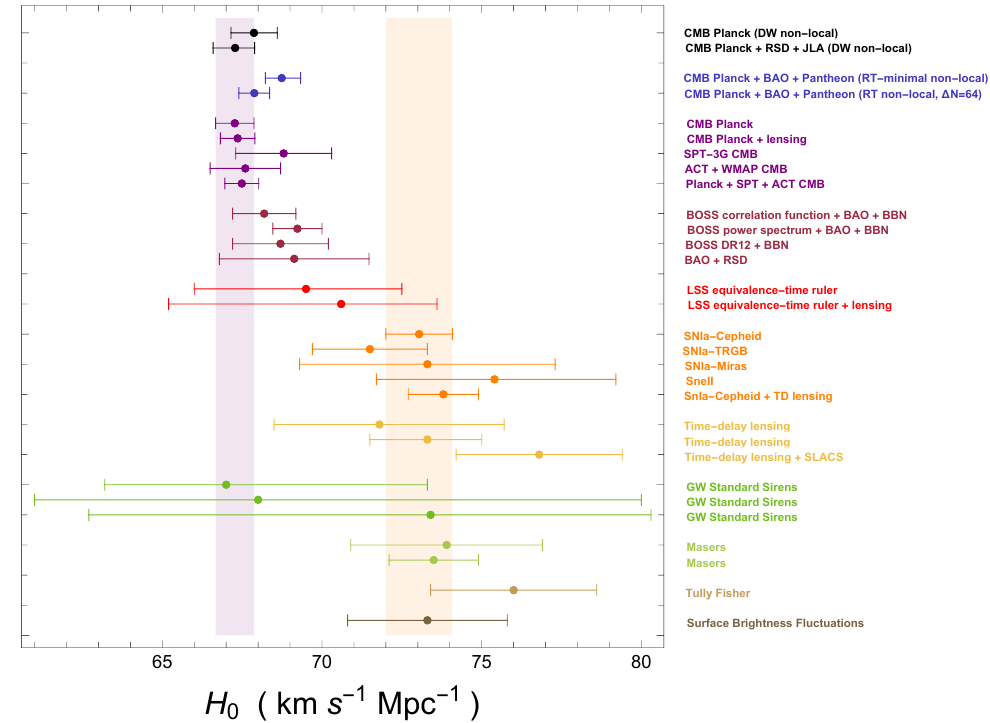
Figure 2. Estimates of H 0 provided by the two non-local cosmological analyses [56,98], and the Λ CDM fit of the CMB [5,66,105,107], the matter power spectrum combined with BAO [20,110,126] and RSD [127], the Large Scale Structure t eq standard ruler [128,129], the supernovae [17,121,124,130,131], the time-delay lensing [121,132,133], the gravitational waves [134–136], the water megamasers [125,137], the Tully–Fisher relation [138] and the SBF [139]. The colored bands correspond to the H 0 estimates derived by the Planck–CMB analysis in the Λ CDM framework (purple) [5] and the SNIa–Cepheids analysis by SH0ES (orange)